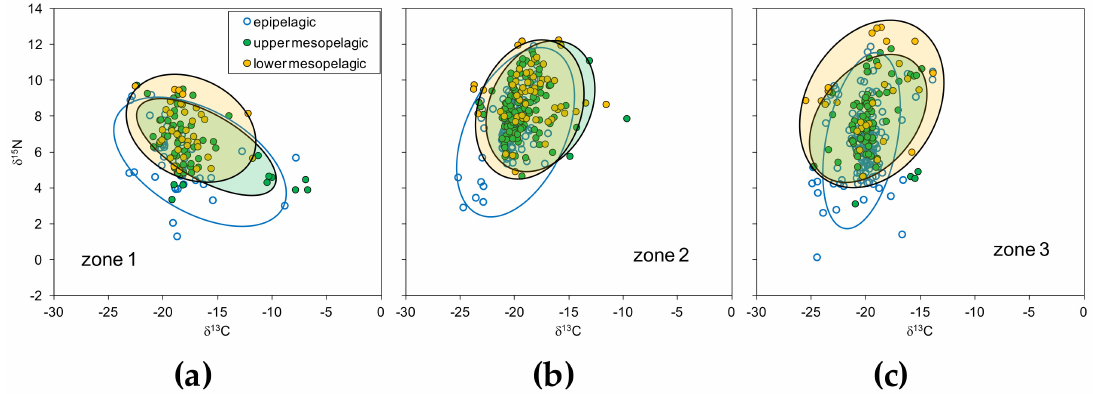
Figure 5. The depth layer isospaces of δ 13 C and δ 15 N including individual sample measurements for seston and plankton for ( a ) zone 1, ( b ) zone 2, and ( c ) zone 3. The maximum likelihood estimates of standard ellipse areas (thick lines) for each layer are indicated.